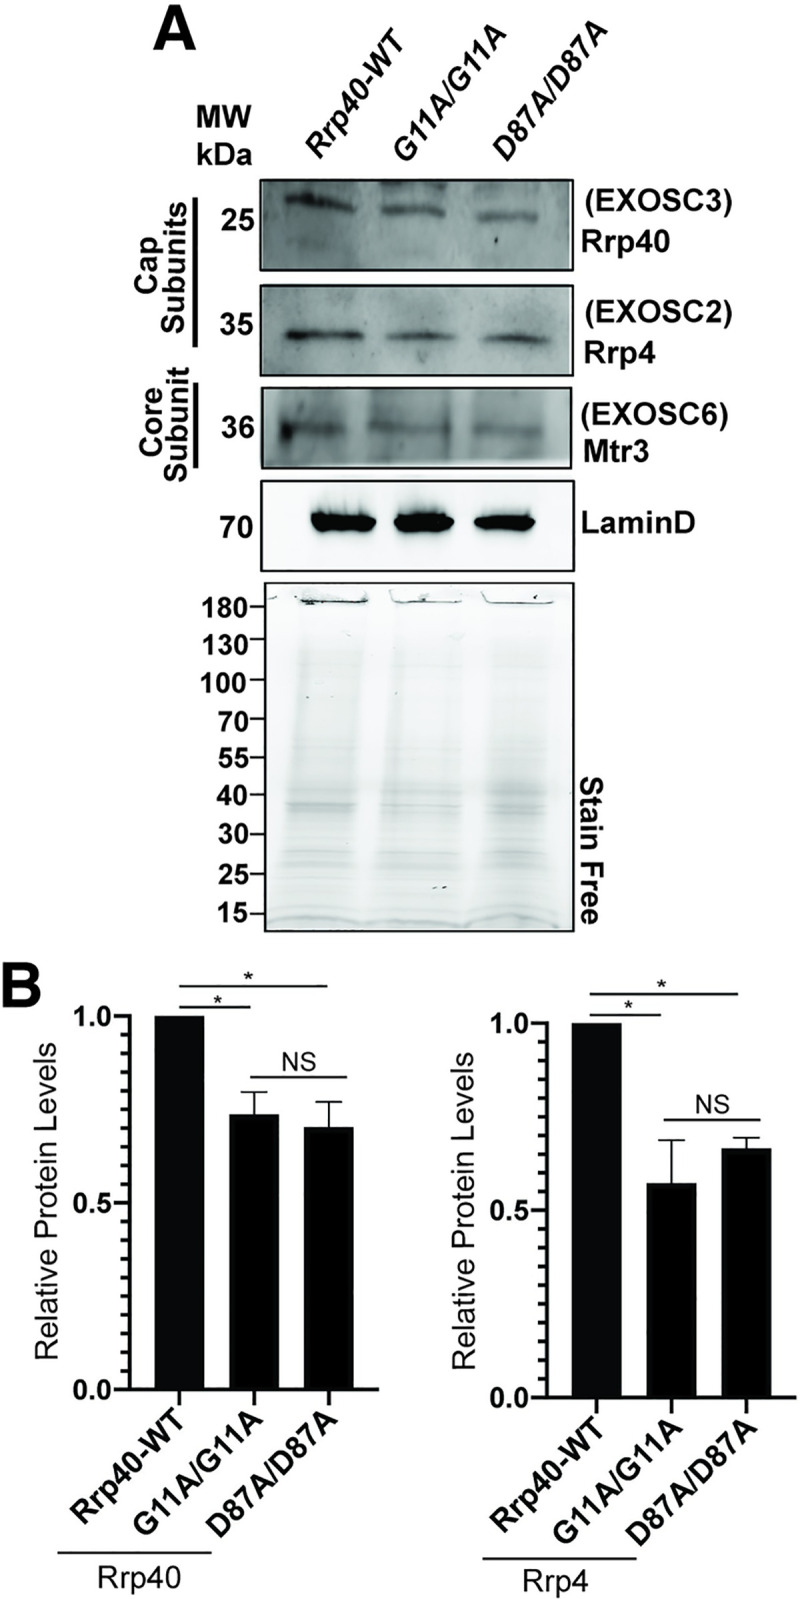
Amino acid substitutions that model PCH1b in Rrp40 alter levels of RNA exosome subunits.(A) Lysates prepared from heads of control Rrp40wt or Rrp40 mutant flies were resolved by SDS-PAGE and analyzed by immunoblotting with antibodies to detect RNA exosome Cap Subunits, Rrp40/EXOSC3 and Rrp4/EXOSC2, and Core Subunit Mtr3/EXOSC6. Both LaminD and Stain Free, as a measure of total protein, serve as loading controls. (B) Results from (A) were quantitated for RNA exosome cap subunits levels (Rrp40 and Rrp4- bands for Mtr3 had too much background to yield reproducible results) and are presented as Relative Protein Levels with the value from the control Rrp40-WT flies set to 1.0. Asterisks (*) indicate results that show statistical significance at *p-value< 0.05. Results that show no statistical significance when compared are indicated by NS.